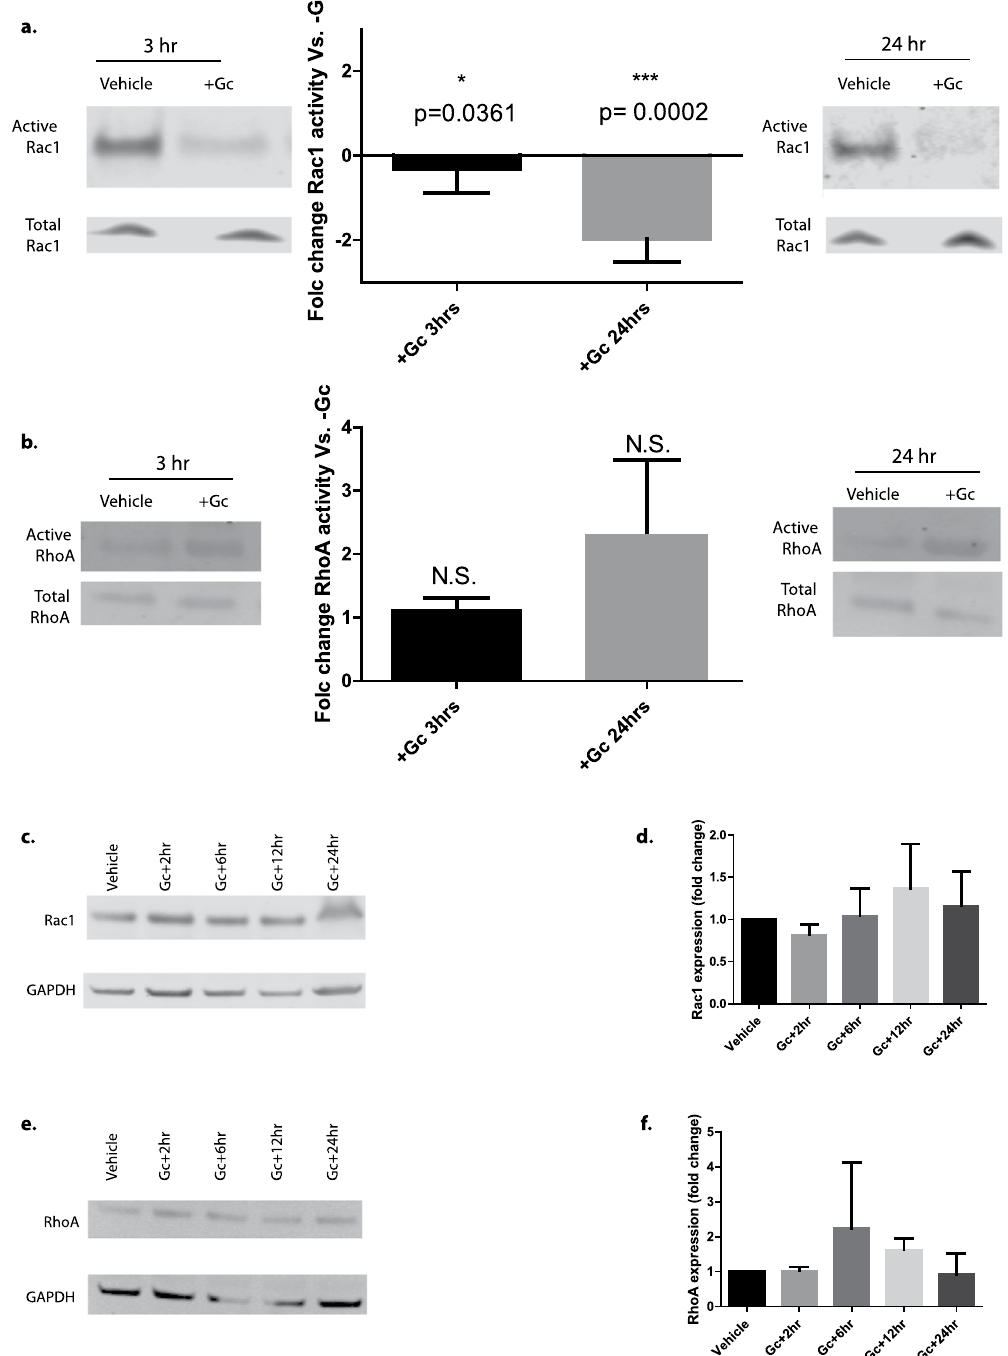
Figure 6. Gc effects on Rac1 and RhoA activity and expression. To understand effects of Gc exposure on the activity of two key regulators of cell motility, Rac1 and RhoA, pull-down assays using beads specific for the active form of these proteins was performed. This allowed quantification of the active protein: total protein. ( a ) Demonstrates Rac1 activity at 3 hours and 24 hours following Gc exposure. ( b ) Demonstrates RhoA activity at 3 hours and 24 hours following Gc exposure. Results were analysed using the nonparametric Mann-Whitney U test: vehicle-control treated cells were compared with Gc-treated cells at the 3 hour time point, and separate vehicle-control treated cells were compared with Gc-treated cells at the 24 hour time point for each experiment. The experiment was performed at least six times. N.S. = not significant. Western blot ( c ) and quantification ( d ) of total Rac1 expression following Gc exposure (n = 3), and western blot ( e ) and quantification ( f ) of RhoA expression (n = 2), showed no significant change in expression following analysis using one way ANOVA and Dunnett’s multiple comparisons test for any time point measured. Error bars represent standard error of the mean. Full length western blots are provided in Supplementary Figure